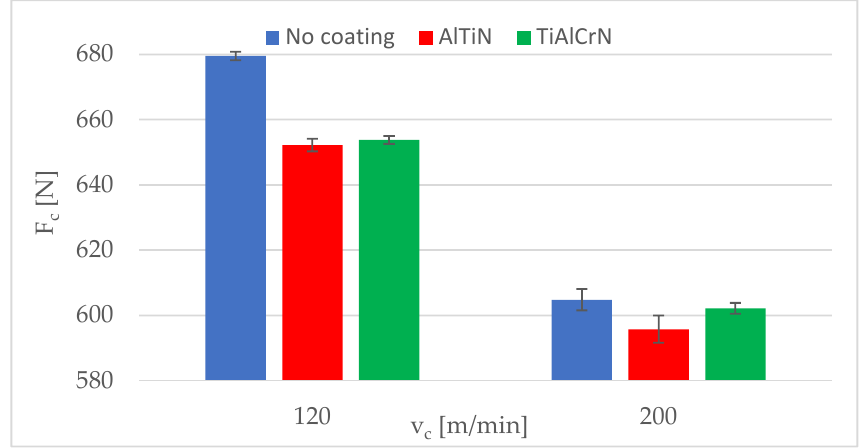
Figure 8. Experimental cutting force values for a feed per revolution of 0.12 mm.